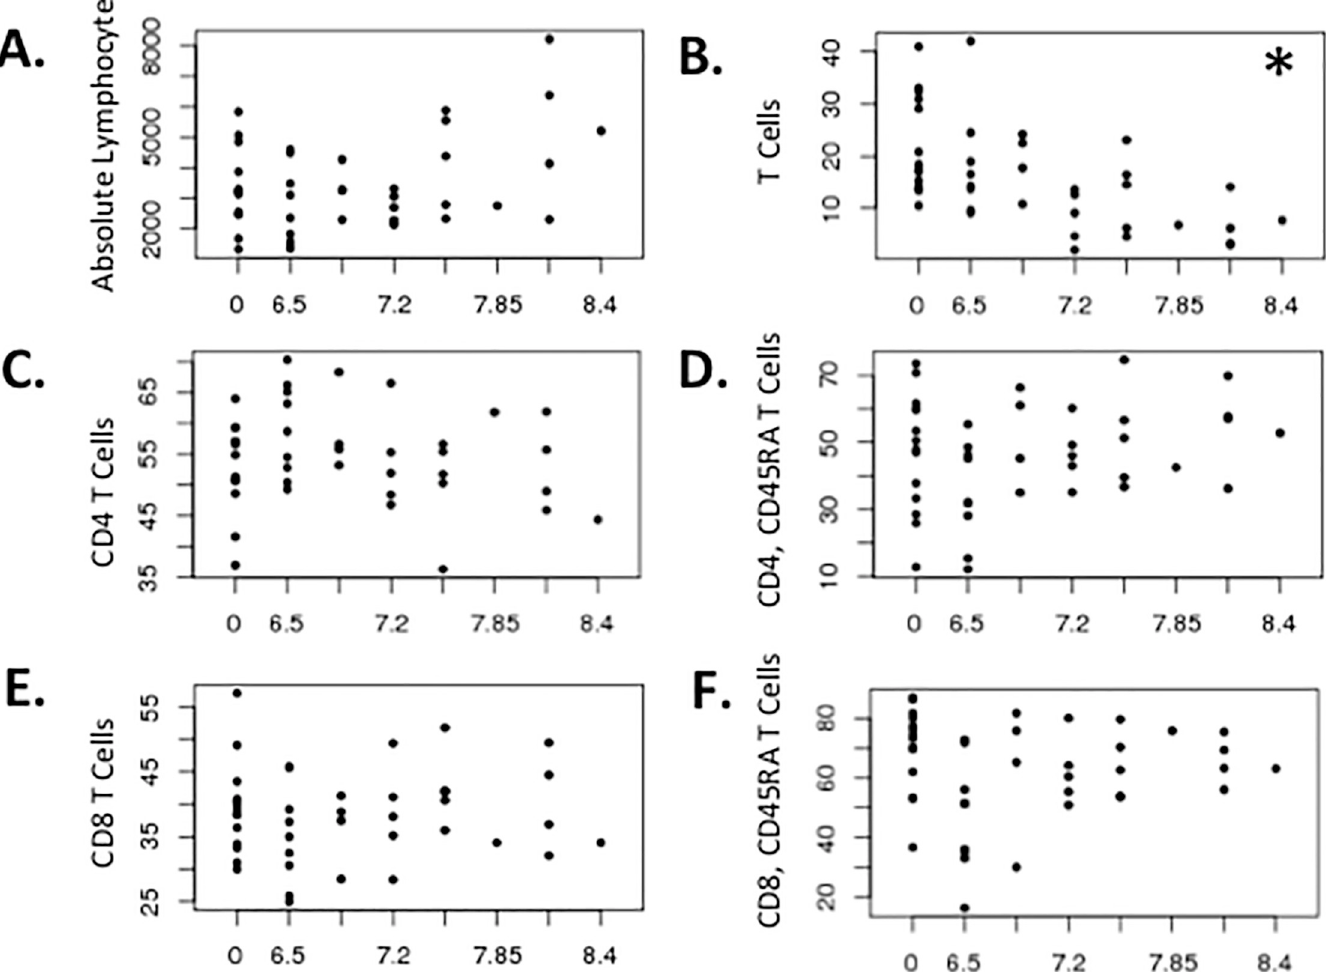
Fig 3. Lymphocyte subset recovery at a median of 55 months (~ 5 years) post-irradiation. Values of each parameter as determined by complete blood count ( A ) or flow cytometry of peripheral blood mononuclear cells isolated by density gradient centrifugation ( B–F ) are shown as a function of radiation dose in Gy as the x-axis for all plots. Each point represents a different subject (n = 43). A . Absolute lymphocyte counts, cells x 10 6 / μ L; B . T cell %; C . CD4 T cell %; D . CD4 CD45RA high (na ï ve) %; E . CD8 T cell %; F . CD4 CD45RA high (na ï ve) %. � indicates Asterisk ( � ) in panel B indicates p = 0.0004 for dose-based comparison of irradiated and control animals using the Jonckheere-Terpstra test. Raw data are provided in S1